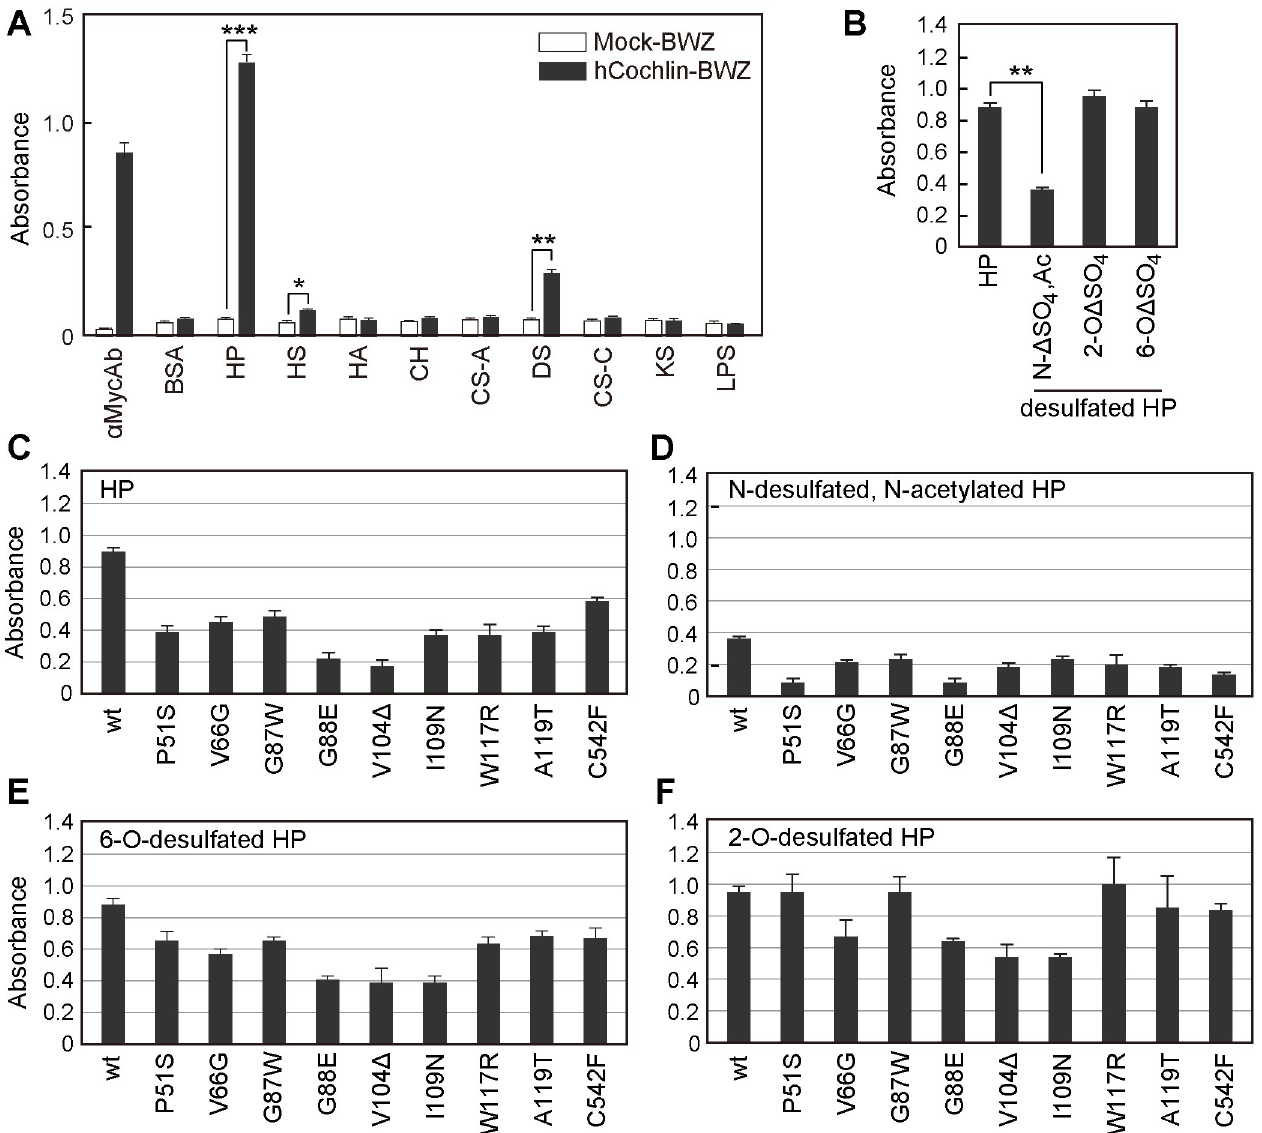
Fig 2. Human cochlin bound to N -sulfated heparin and mutations in DFNA9 patients decreased binding affinity. (A) Reporter assay of the interaction between human cochlin and several extracellular matrices. (B) N -desulfated, N -acetylated heparin significantly decreased binding affinity for cochlin. Each wild-type and mutated cochlin reporter cell was cultured in a well coated with (C) heparin, (D) N -desulfated, N -acetylated heparin, (E) 6- O -desulfated heparin, or (F) 2- O -desulfated heparin for 18 h at 37˚C and β -galactosidase expression was monitored calorimetrically. The data are represented as the mean ± SD of n = 3 independent wells. ��� p < 0.005; �� p < 0.01; � p < 0.05 (Student’s t